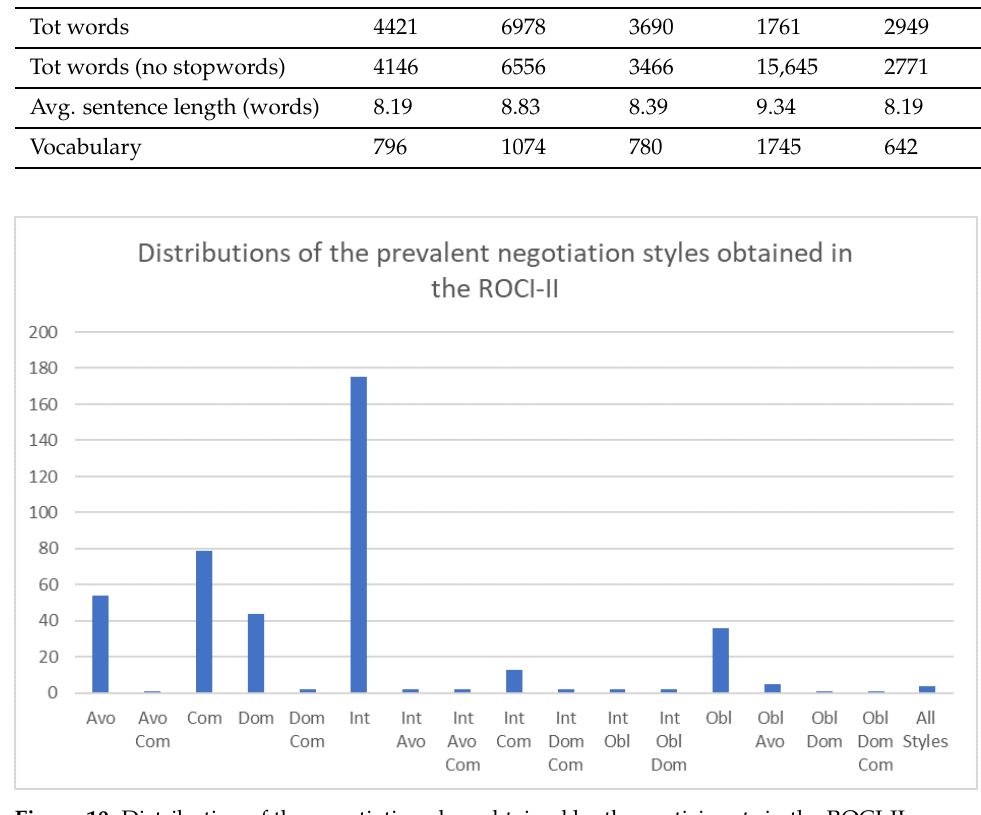
Figure 10. Distribution of the negotiation class obtained by the participants in the